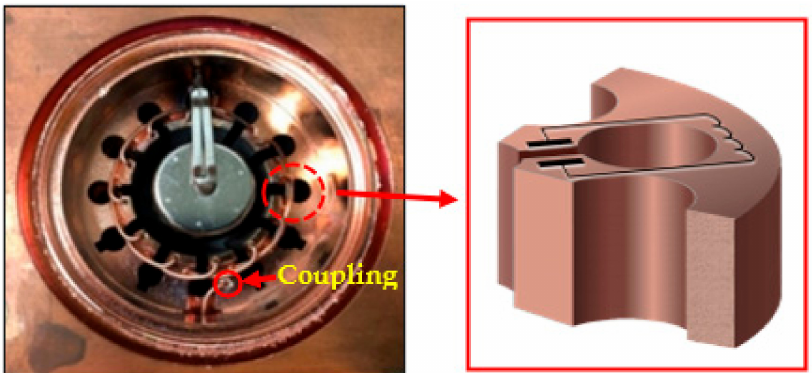
Figure 4. Internal structures of twelve-hole-slot-type magnetron and equivalent circuit of reso- nant cavity.